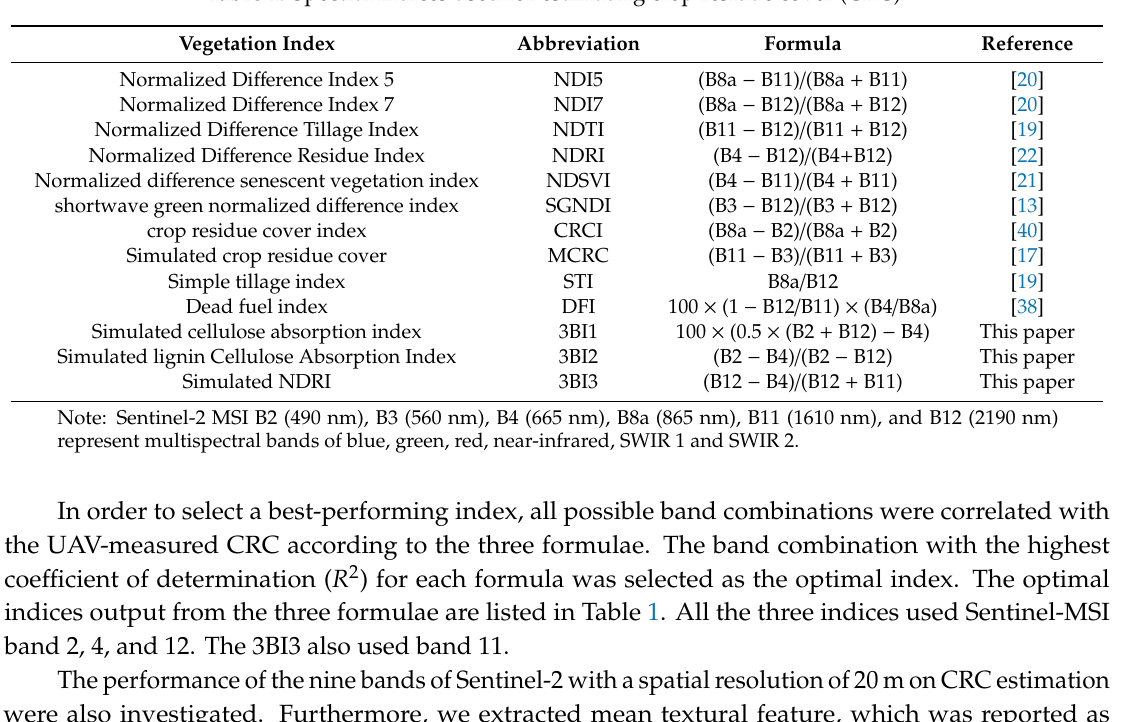
Table 1. Spectral indices used for estimating crop residue cover